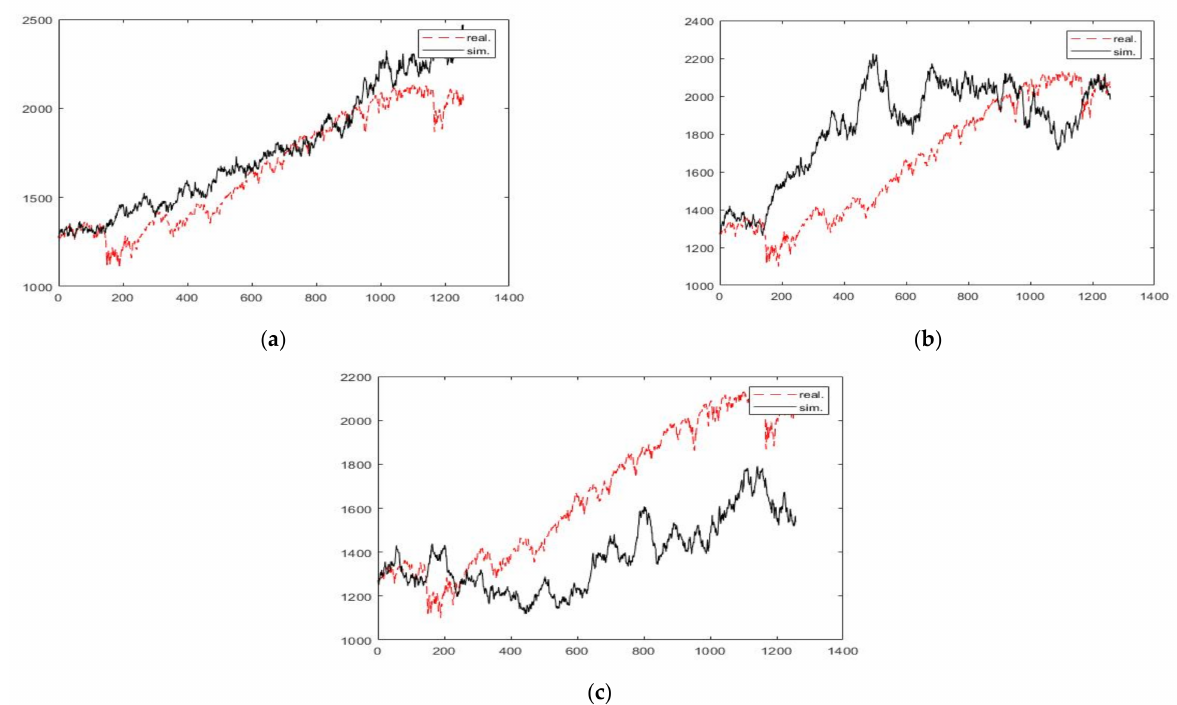
Figure 2. Simulation results using GFBM (5-year period): ( a ) Hurst PE, ( b ) Hurst RS, ( c ) Hurst 0.5.